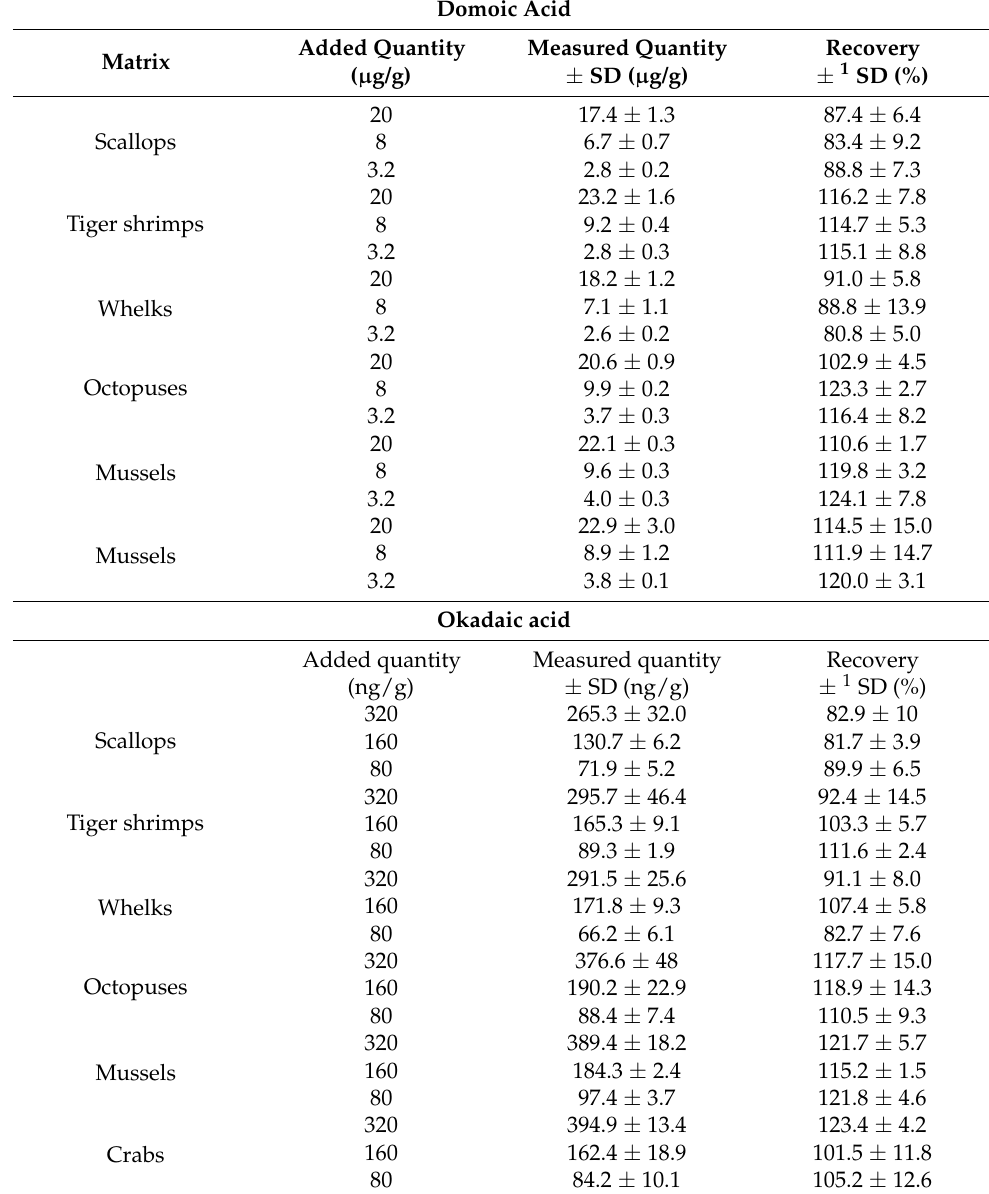
Table 2. Recoveries of DA and OA from seafood (n =